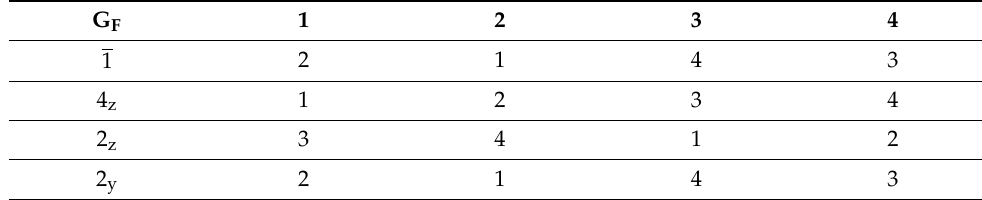
Figure 2. ( a ) I 4/ mmm space symmetry group elements; ( b ) Ca 3 Mn 2 O 7 unit cell, the numbering of Table 3. Permutation transformations ions in positions 4e {4mm}. G F Table 3. Permutation transformations ions in positions 4e {4mm}.